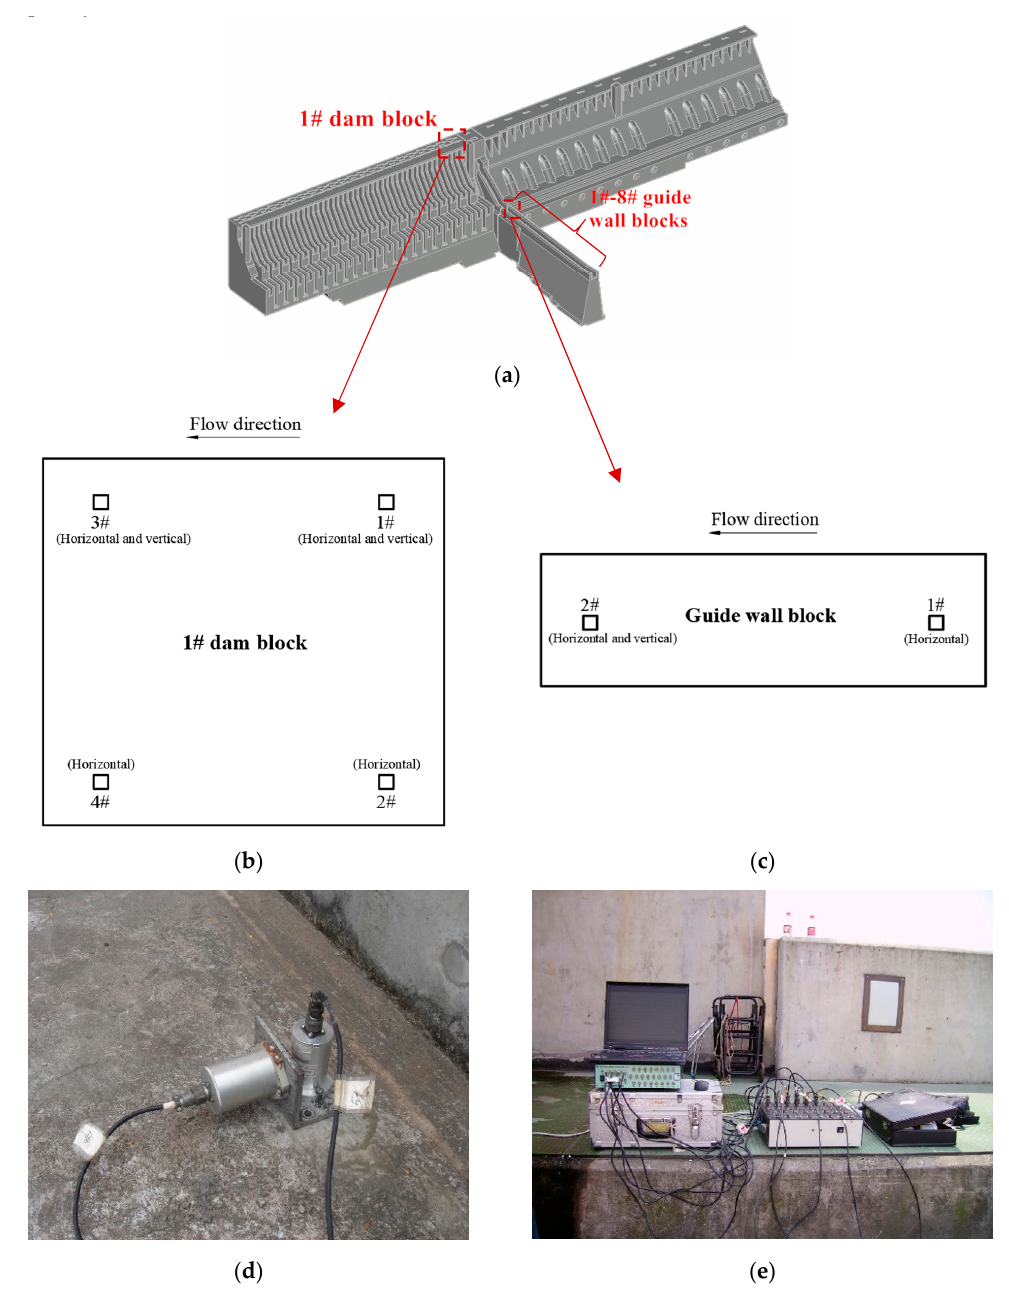
Figure 2. The layout of measuring points. ( a ) The locations of measuring points; ( b ) dam block measuring points; ( c ) guide wall block measuring points (same layout for each block); ( d ) displacement sensor (horizontal and vertical); ( e ) acquisition devices.